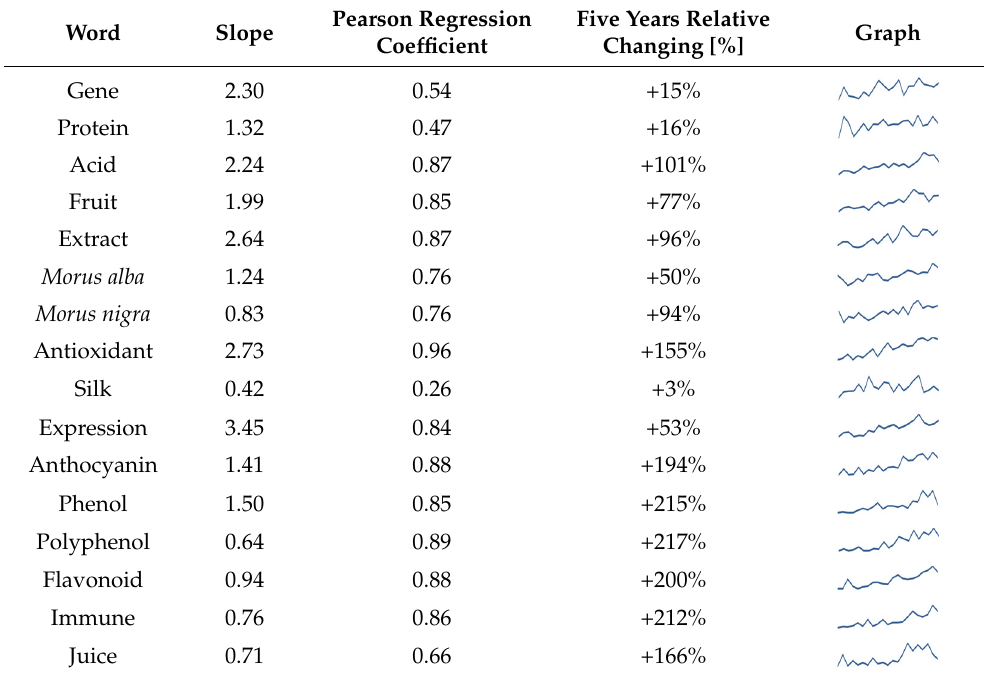
Table 5. Most important words normalized per topic considering their slope, Pearson regression coefficient and their relative increment in the past five years.